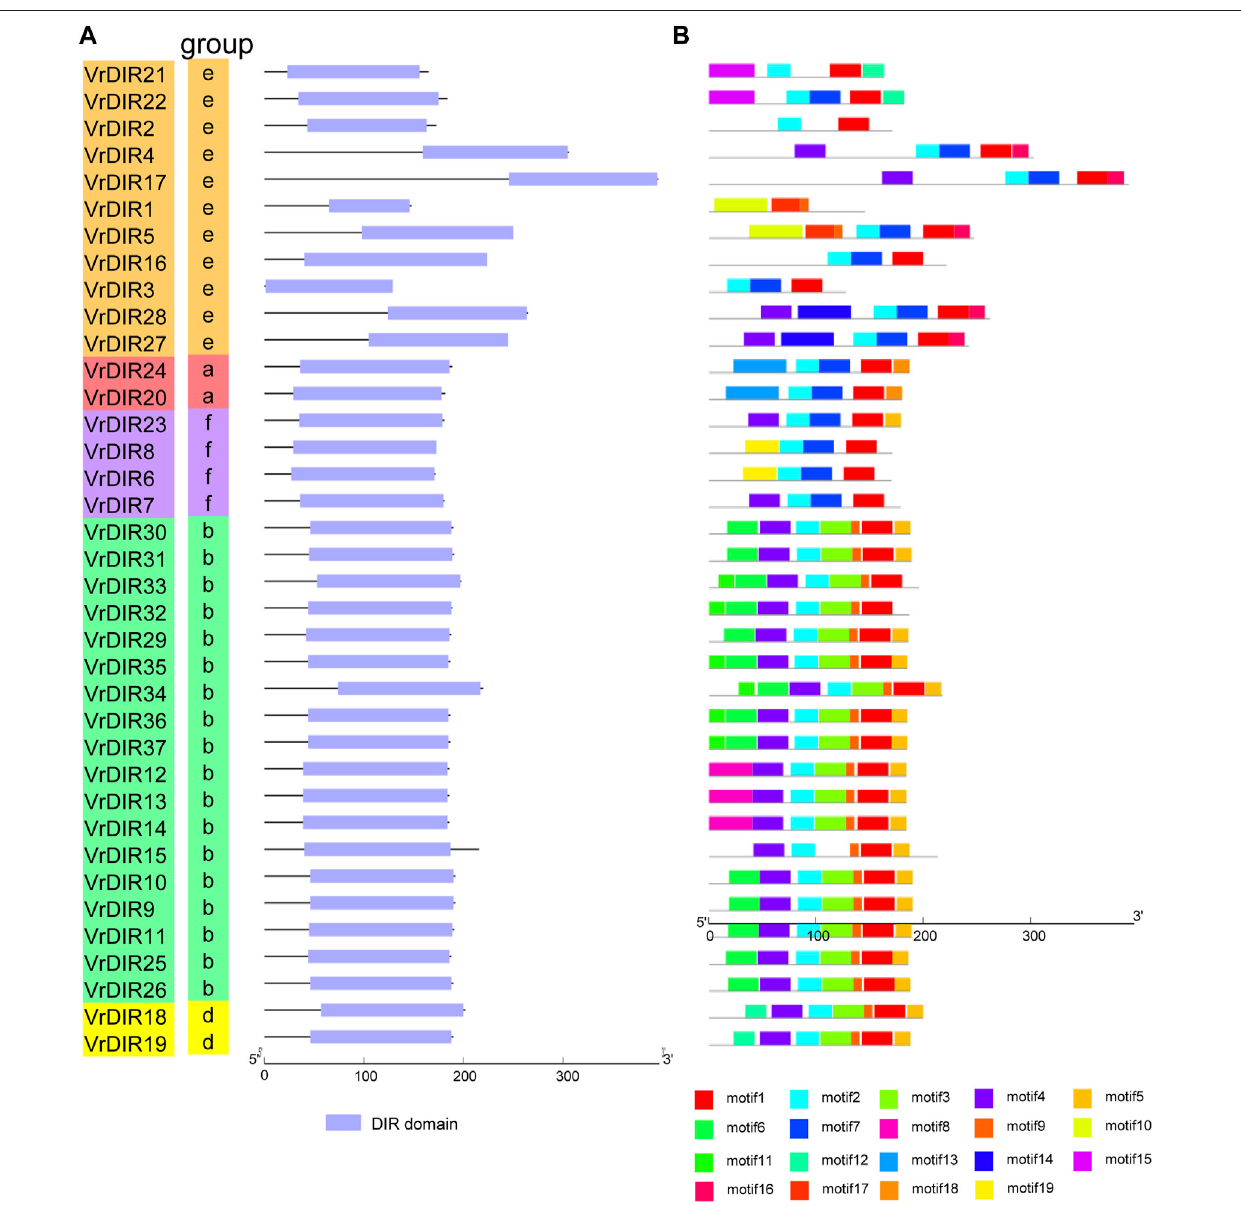
FIGURE 3 | Conserved domain and motif analyses in VrDIR proteins. (A) The positions and lengths of the conserved DIR domains in VrDIR proteins. The light blue boxesindicatetheconservedDIRdomains. (B) TheconservedmotifsinVrDIRproteins.The19motifsareindicatedusingdifferentcoloredboxes.ThelengthofeachDIR protein is